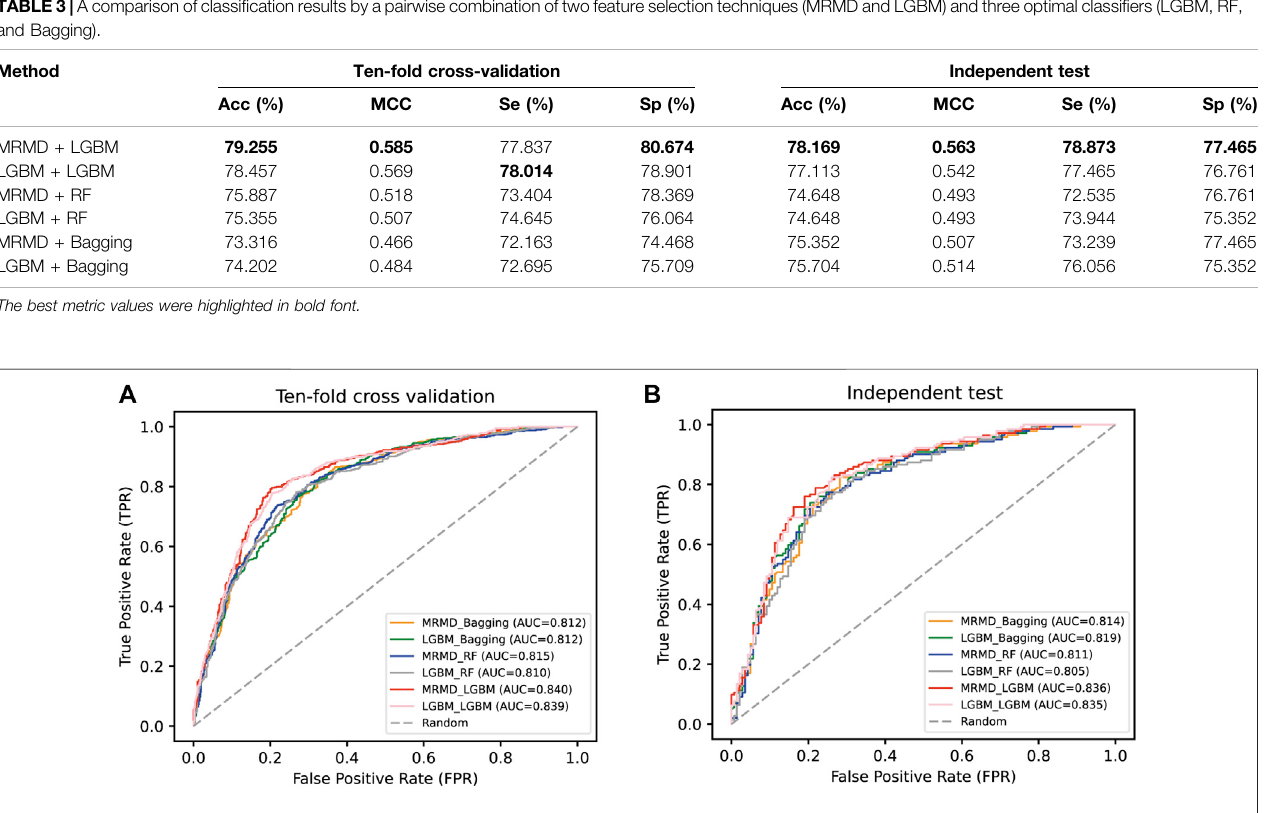
Frontiers in Genetics |